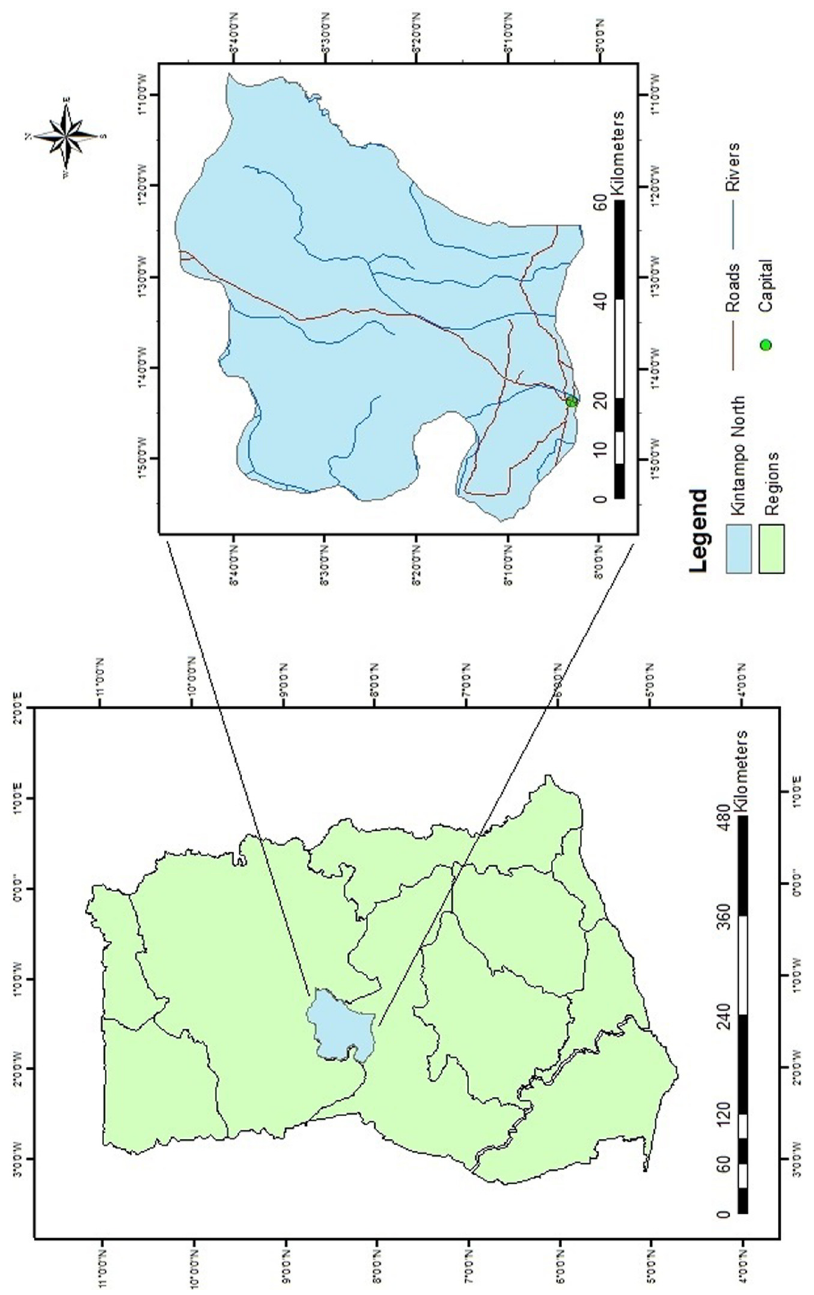
Figure 1. Map of Ghana showing study